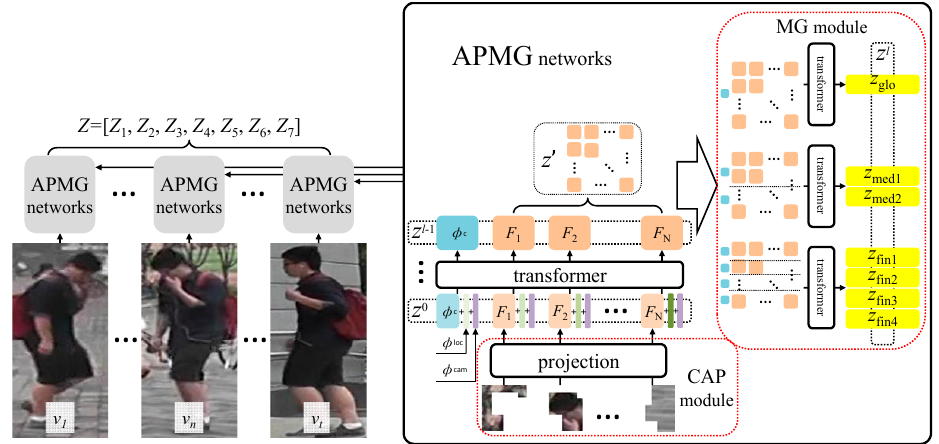
Figure 2. The overall framework of the APMG network.